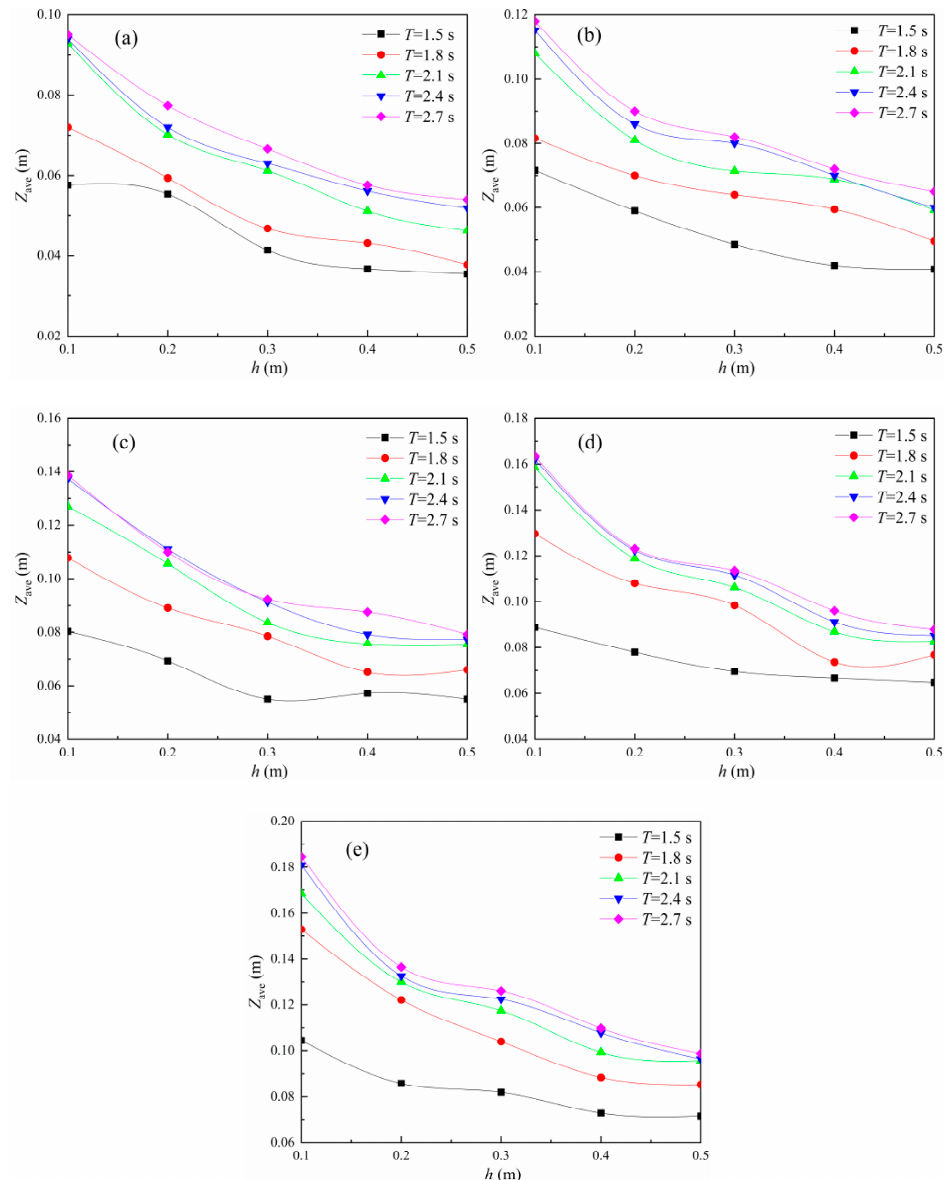
Figure 7. Z ave relationship with h . ( a ) H = 0.18 m; ( b ) H = 0.20 m; ( c ) H = 0.22 m; ( d ) H = 0.24 m; ( e ) H = 0.26 m.